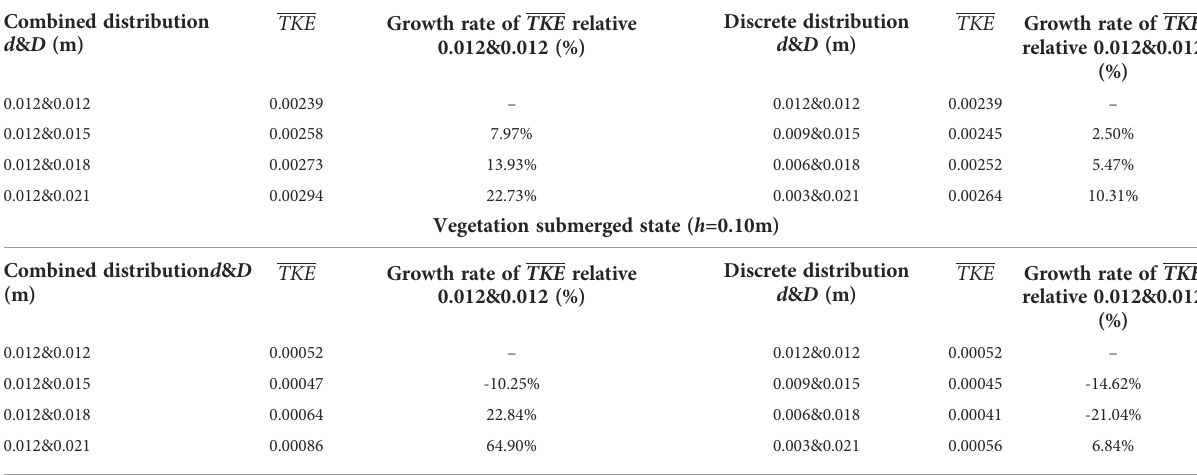
TABLE 4 The average turbulent kinetic energy TKE value and its rate of change at longitudinal section L3 under different submerged states and different distribution modes.